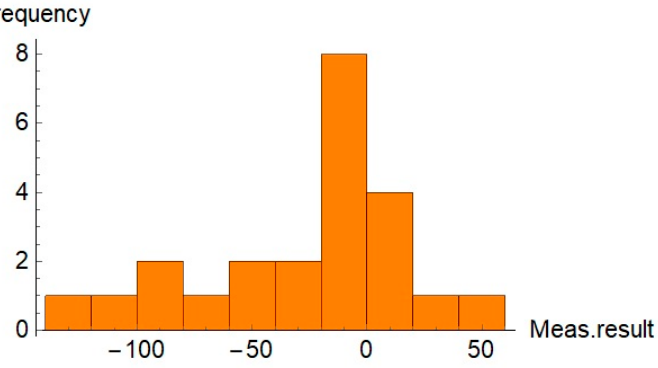
Figure 8. Histogram of the relative differences between compared results for the first set of the parts.